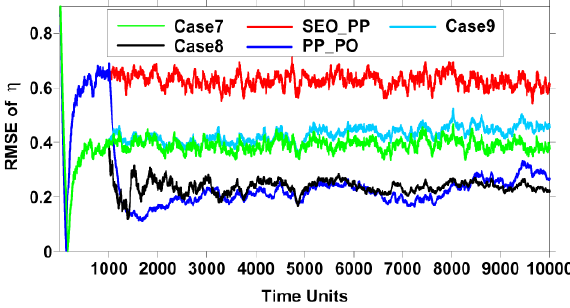
Fig. 9. Time series of RMSEs of η in 10 4 TUs in Case7 (green line), Case8 (black line), and Case9 (cyan line). The setups of the three experiments are described in Table 1. Note that the time series of RMSEs of η in SEO_PP (red line) and PP_PO (blue line) are also plotted as references.